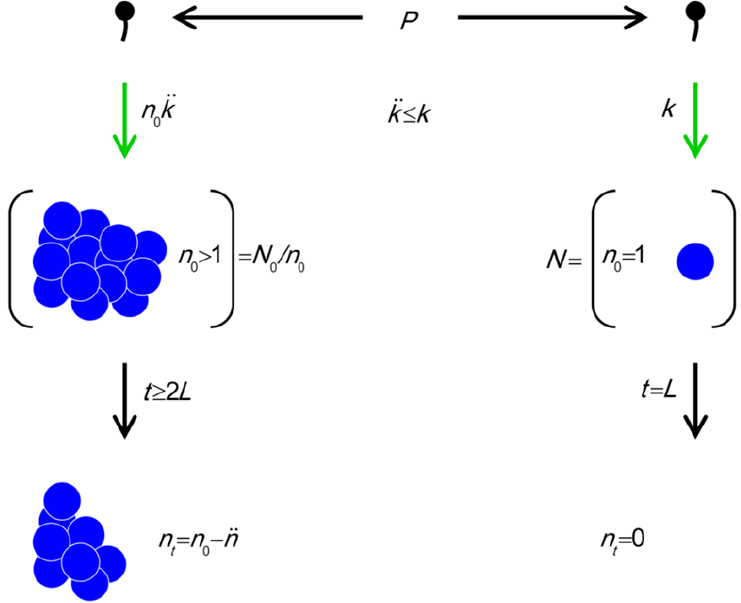
Figure 4. The model. Parameters include P (density of phages in environment), k (phage adsorption constant), (cid:1863)(cid:4663) (phage adsorption constant considering reductions due to shading of bacteria by bacteria found within bacterial arrangements), n (number of bacteria found per arrangement), N (bacterial density of overall environment), L (phage latent period, which is the duration of a phage infection), and (cid:1866)(cid:4663) (number of bacteria per arrangement lost subsequent to phage infection of one cell in the arrangement). Likelihood of phage adsorption of bacterial arrangements is (cid:1866)(cid:1863)(cid:4663) and density of arrangements within (cid:1863)(cid:4663) and (cid:1840) , respectively, to reflect environments is equal to (cid:1840)/(cid:1866) (cid:3404) (cid:1840) /(cid:1866) (or indeed (cid:1866) /(cid:1866) (cid:2868) (cid:2868) (cid:2868) (cid:2868) that (cid:1866) changes as a function of time in the figure). The inequality (cid:1872) (cid:3410) 2(cid:1838) indicates how phage acquisition of bacteria within a bacterial arrangement, according to this model, involves at least two sequential rounds of phage infection. The absence of cells in the lower in the lower left. Both of right is intentional as too is the reduction in cell number to (cid:1866) (cid:3047) these reductions in cell number, going from middle to bottom, indicate phage-induced bacterial